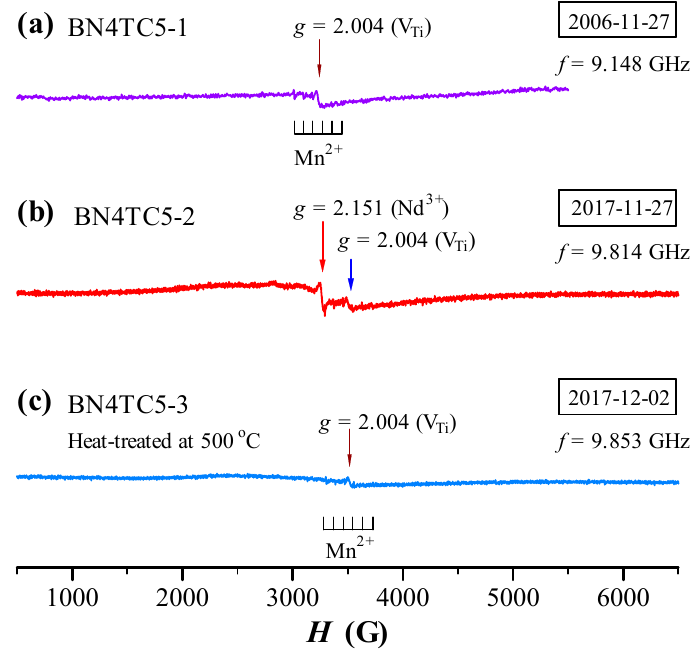
Figure 4. ESR spectra of BN4TC5, measured in ( a ) 2006 using a JES-RE3X spectrometer (JEOL) and in ( b , c ) 2017 using an A300-10/12 spectrometer (Bruker, Billerica, MA, USA).